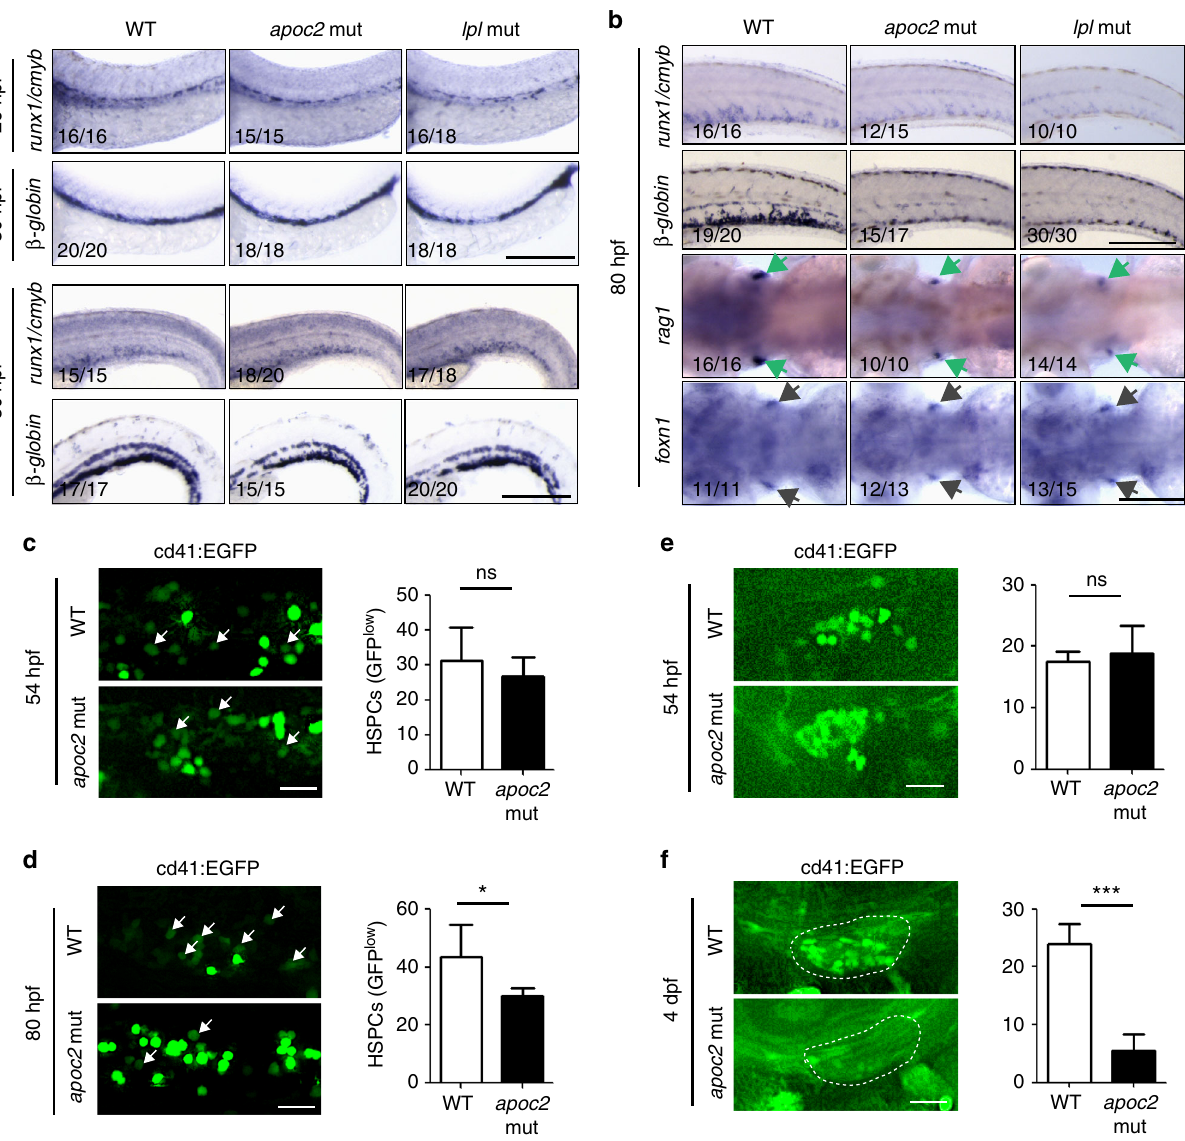
Fig. 3 Hematopoietic defects in apoc2 and lpl mutants occur during HSPC expansion. a In situ hybridization with cmyb/runx1 and β -globin probes in WT, apoc2 and lpl mutants at 26 hpf, 30 hpf and 50 hpf. b In situ hybridization with cmyb/runx1 , β -globin , rag1 (green arrows) and foxn1 (black arrows) probes in WT, apoc2 and lpl mutants at 80 hpf. foxn1 is a thymus development marker, used as a control. c , d Representative images and numbers of GFP low cells (HSPCs, white arrows) in the CHT region of cd41: EGFP transgenic WT and apoc2 mutants at 54 and 80 hpf ( n = 10 in WT and n = 8 in apoc2 mutant groups at 54 hpf; n = 6 in each group at 80 hpf). e , f Representative images and numbers of GFP-positive cells in the thymus region at 54 hpf ( n = 9 in WT and n = 8 in apoc2 mutant groups) and at 4 dpf ( n = 8 in each group). Scale bars, 200 μ m in a and b ; 50 μ m in c – f . Mean± SEM; * P < 0.05 and *** P <